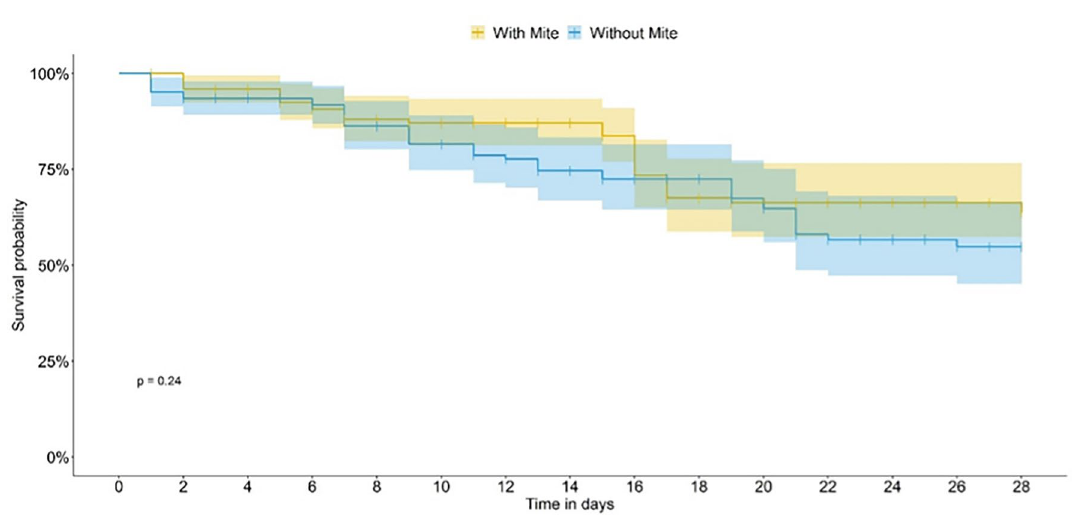
Figure 3. Scaptotrigona postica survivorship in the presence (with mites) and in the absence (without mites) in the thiamethoxam bioassay